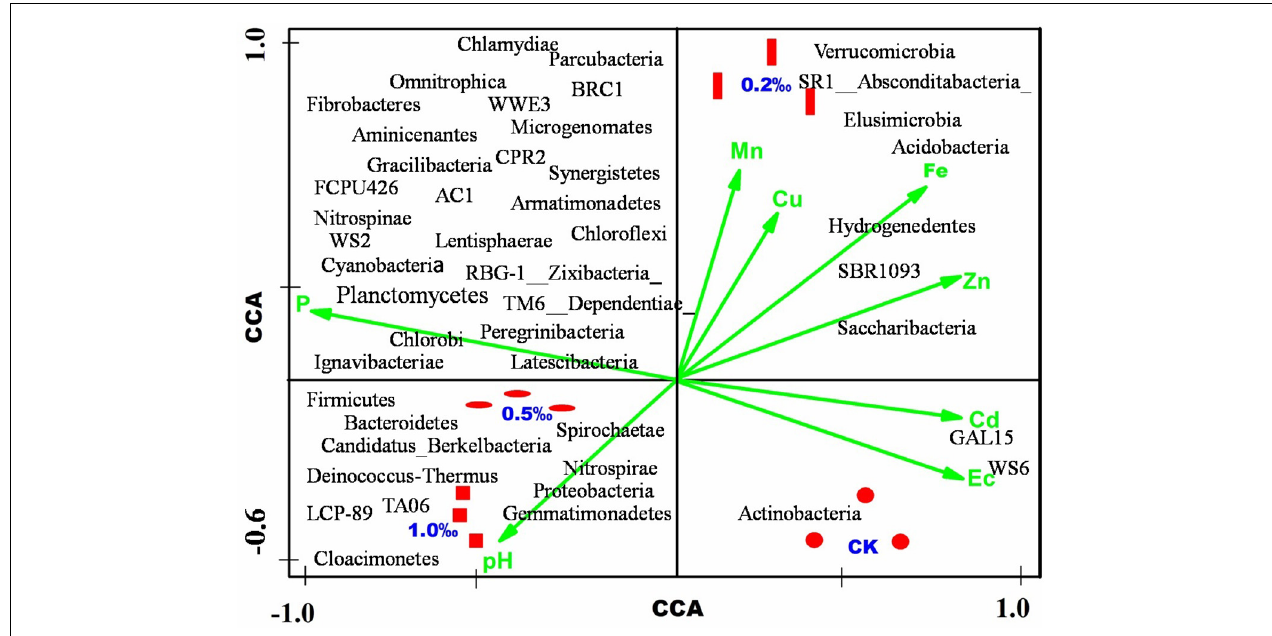
FIGURE 5 | Canonical correspondence analysis (CCA) of the microbial community, environmental parameters, and